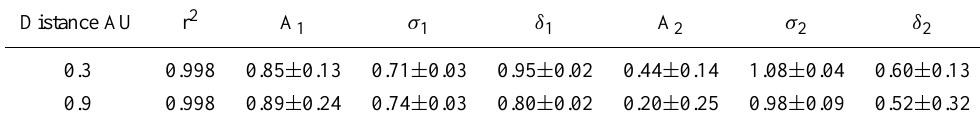
Table 2. Fast Wind: Values of the parameters obtained from the fit of the PDF relative to vector displacements. Distance AU r 2